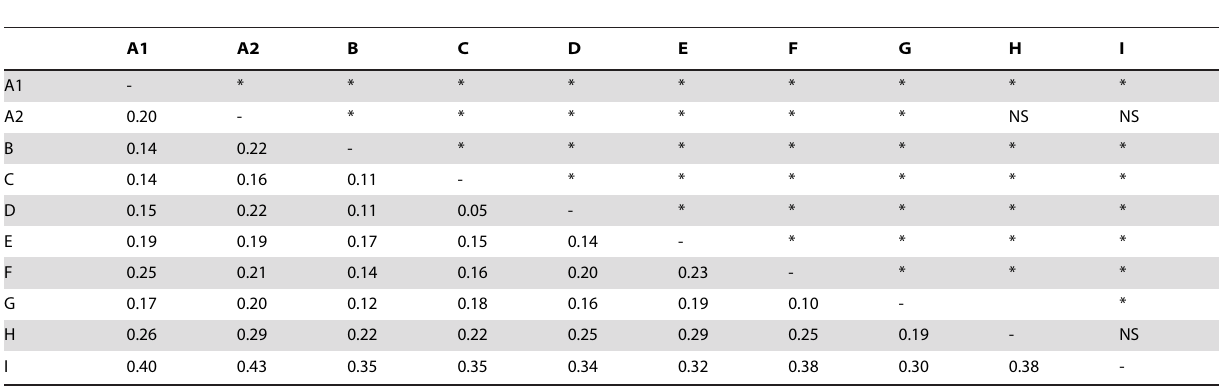
Table 2. Pairwise population differentiation